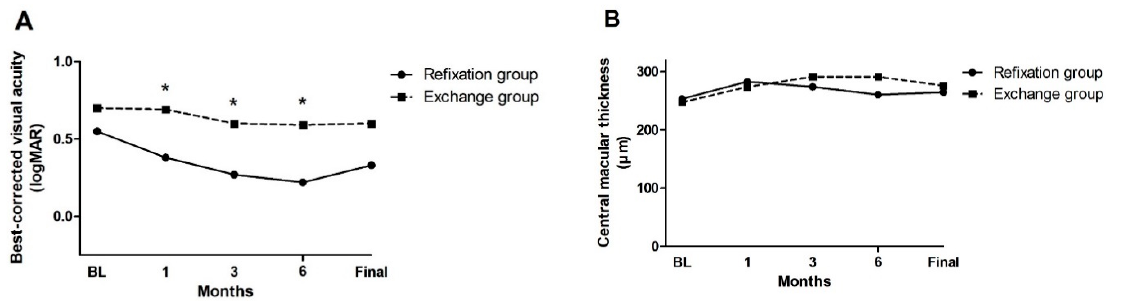
Figure 1. Changes in the mean best-corrected visual acuity ( A ) and central macular thickness ( B )